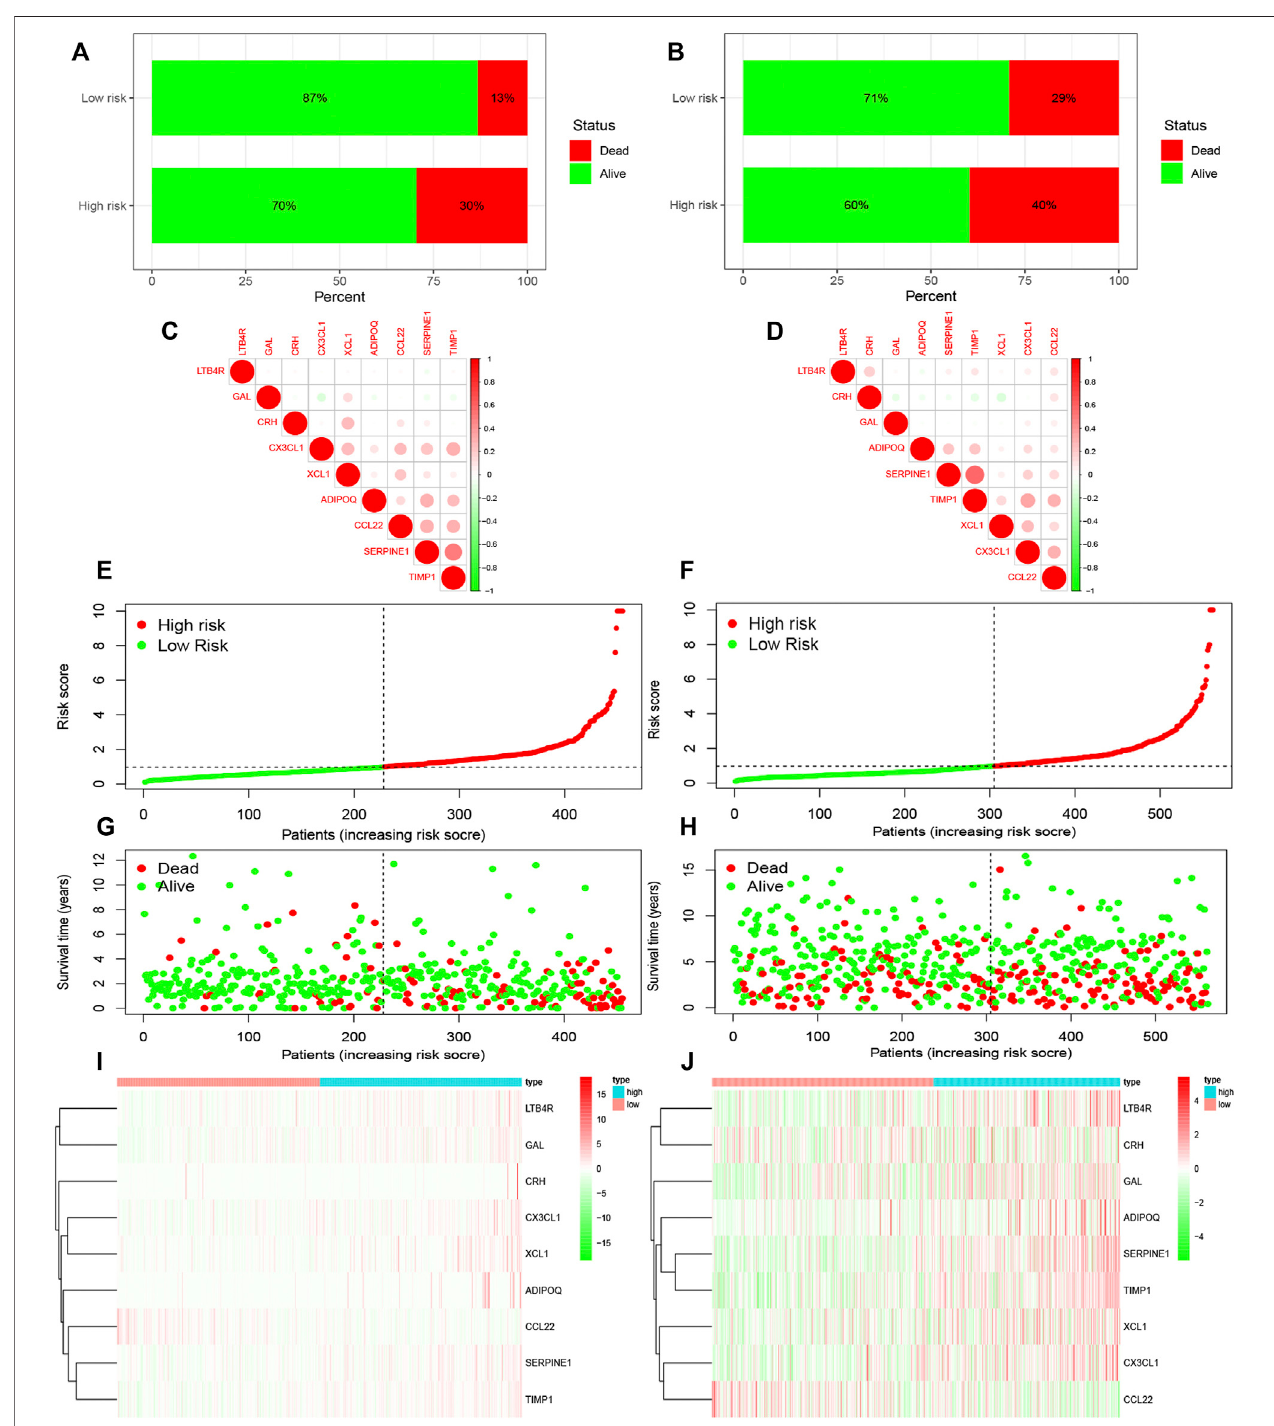
FIGURE 3 | Survival rate and prognosis of patients using the model, along with the expression of genes in the model in the high-risk and low-risk groups. (A,B) Survival rates in the TCGA and GEO databases. (C,D) Relationship between the genes in the model. (E,F) Risk scores of patients in the TCGA and GEO databases. (G,H) Survivaltimeofpatients inthehighandlowriskgroupsintheTCGAandGEO databases. (I,J) Expressionofthegenesinthemodelinthehighandlowriskgroups of the TCGA and GEO databases.